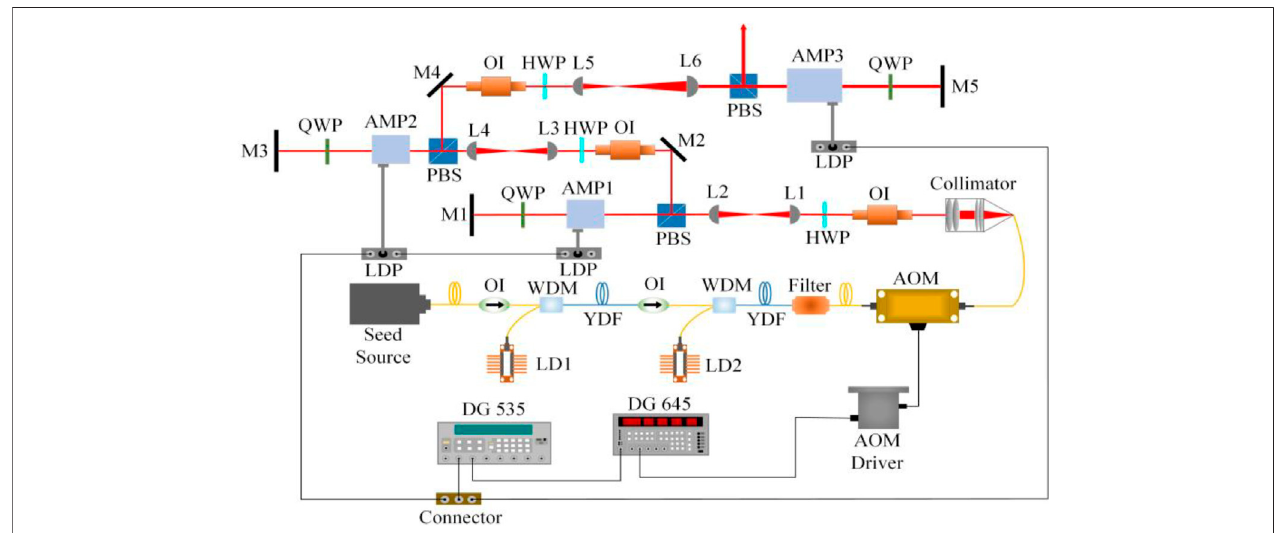
FIGURE 2 | Optical layout of the burst-mode laser system. OI: optical isolator, LD: laser diode, WDM: wavelength division multiplex, YDF: Ytterbium-doped fi ber, AOM: acousto-optic modulator, HWP: half-wave plate, PBS: polarizing beam splitter, QWP: quarter-wave plate, AMP: ampli fi er module, DG: delay generator, and LDP: laser diode power